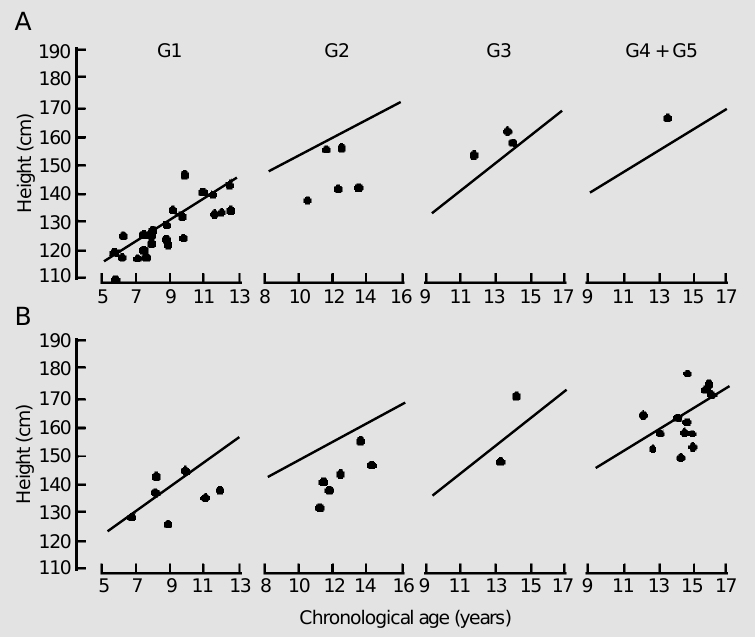
Figure 2. Height in relation to age and pubertal stage (Tanner’s classification; G1 to G4 + G5) at diagnosis (A) and at final evaluation (B) in type 1 diabetic boys. G1-G5: genital develop-